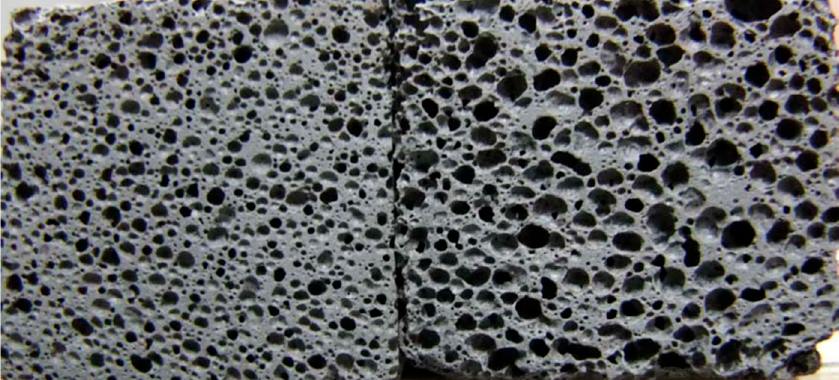
Figure 2. Photography of polished sections of GLWC of 900 kg / m 3 (left) and 600 kg / m 3 (right). The length and width of GLWC are 4 cm.